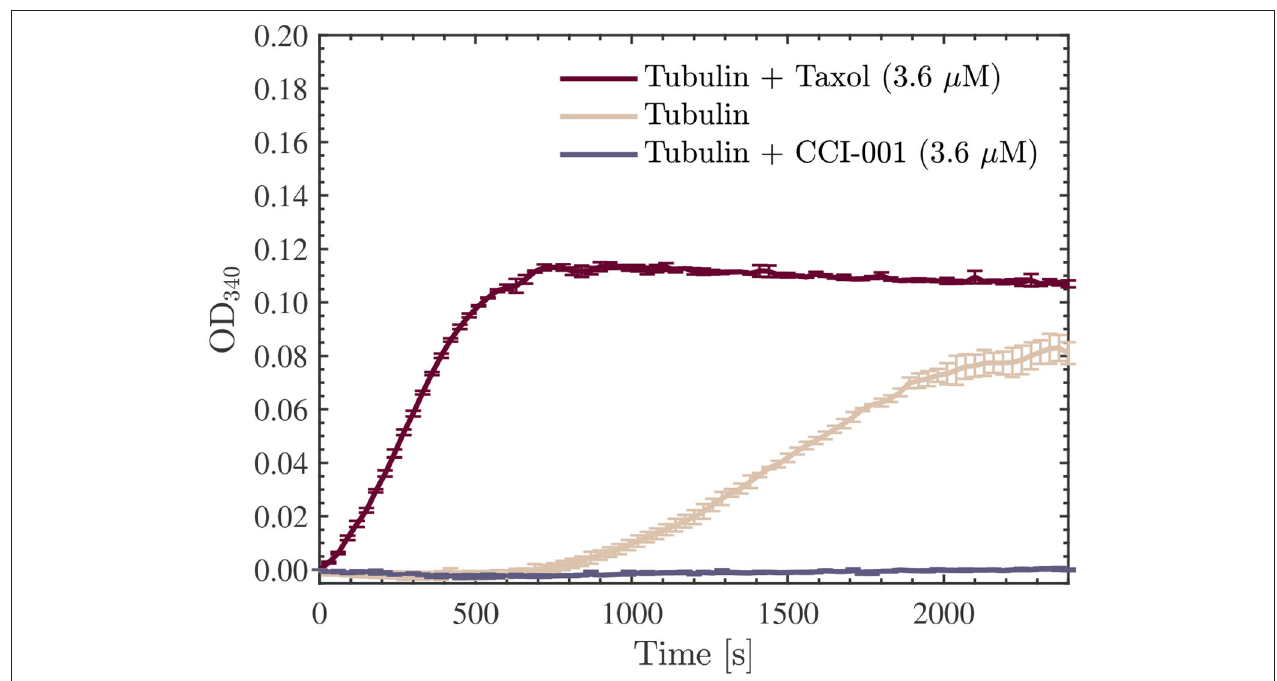
FIGURE 8 | Average optical density results obtained for absorbance measurements performed at 340 nm, every 30 s for 40 min, using a SpectraMax iD5 microplate reader. The red, beige, and purple curves presented are for the 22.7 µ M tubulin samples measured in all three scenarios discussed: Taxol-stabilized (3.6 µ M), drug-free, and CCI-001 (3.6 µ M), respectively. The data presented was collected in N = 1 independent replicate experiments.